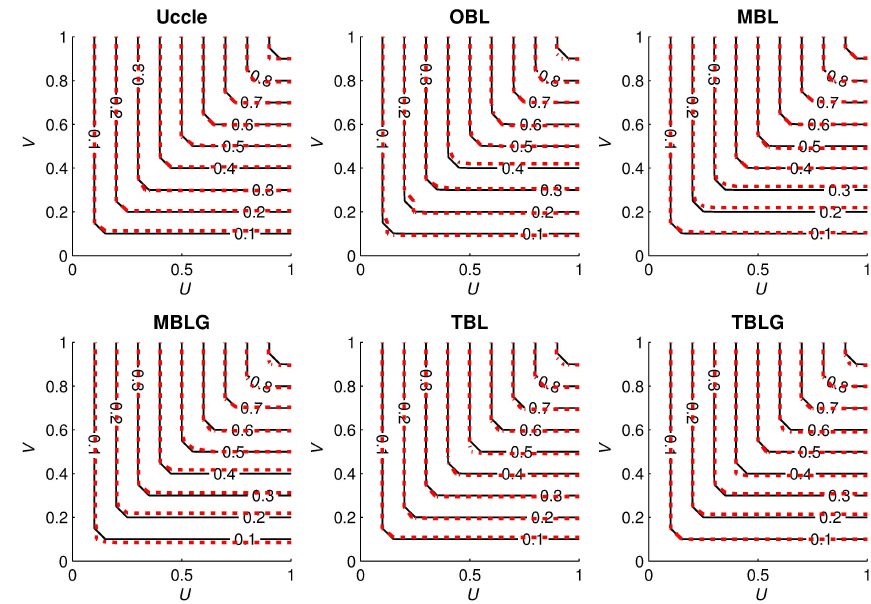
Fig. 8. Fitted Frank copulas (full line) and empirical copulas (dotted red line) for all data set. Table 7. p values for the AD n statistic test ( p values larger than 0.05 indicating an appropriate fit of the distribution are displayed in bold). Variable Duration ( D ) Severity ( S ) distribution